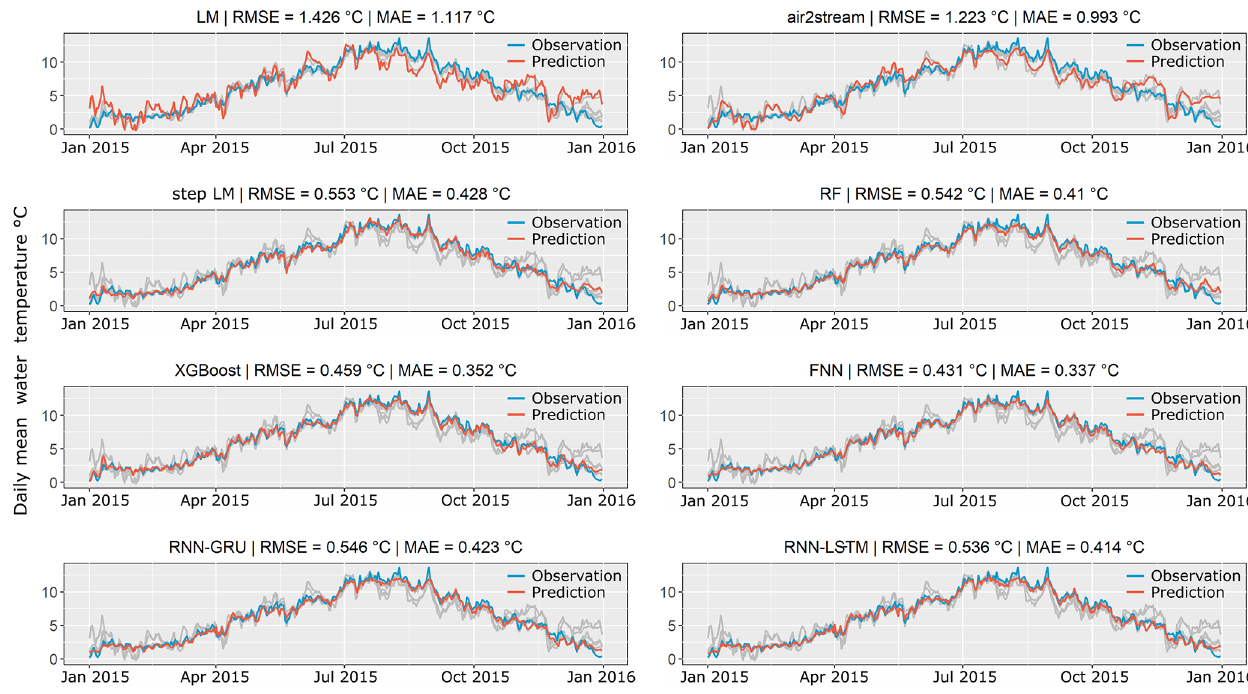
Figure 5. Comparison of the prediction of all tested model types for the Inn catchment for the year 2015. Data from 2015 were not used for training and validation. Prediction results for each model are shown with red lines, while the observations are shown in blue lines. The predictions of all other models are illustrated with grey